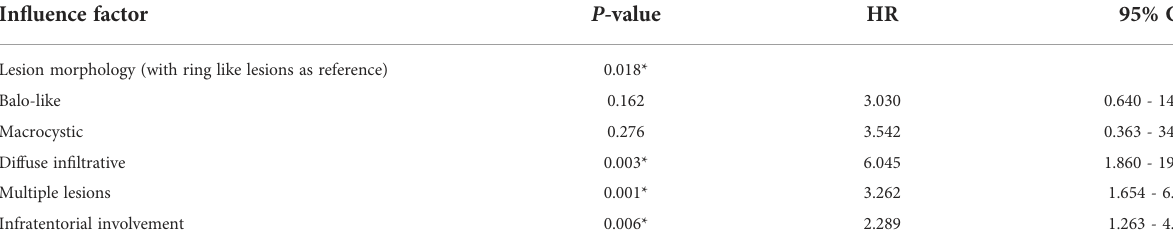
TABLE 3 Multivariate analysis of risk factor screening for relapse of TDLs. In fl uence factor P -value Lesion morphology (with ring like lesions as